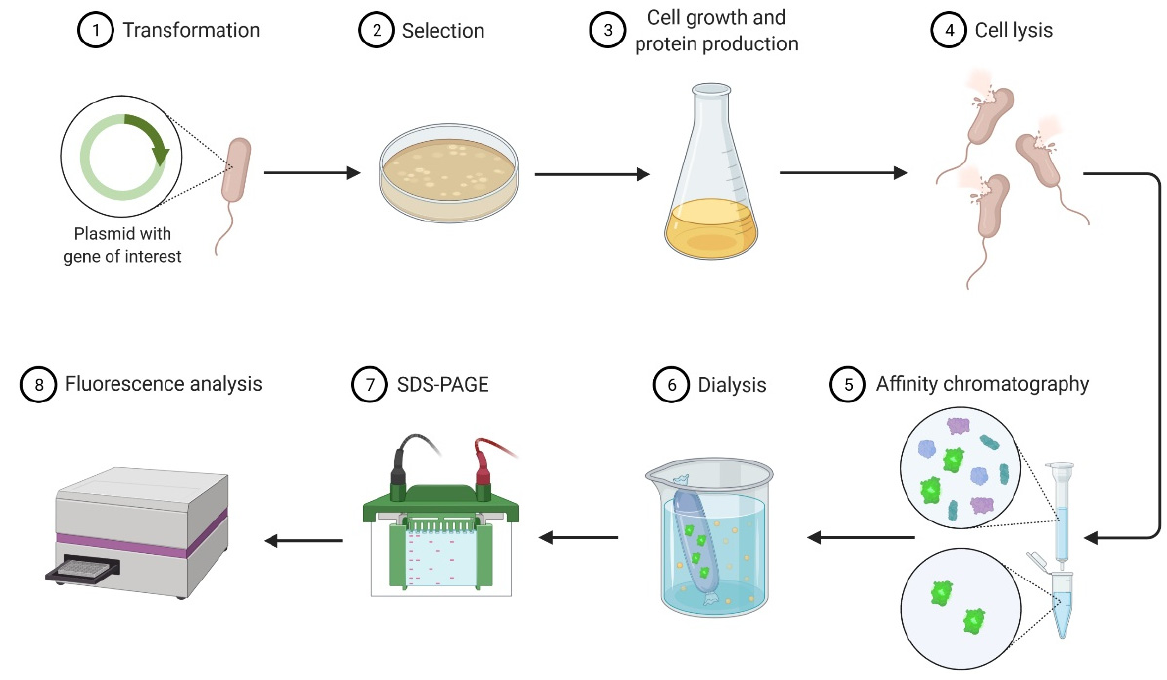
Figure 1. Outline of recombinant protein production and purification in Escherichia coli .